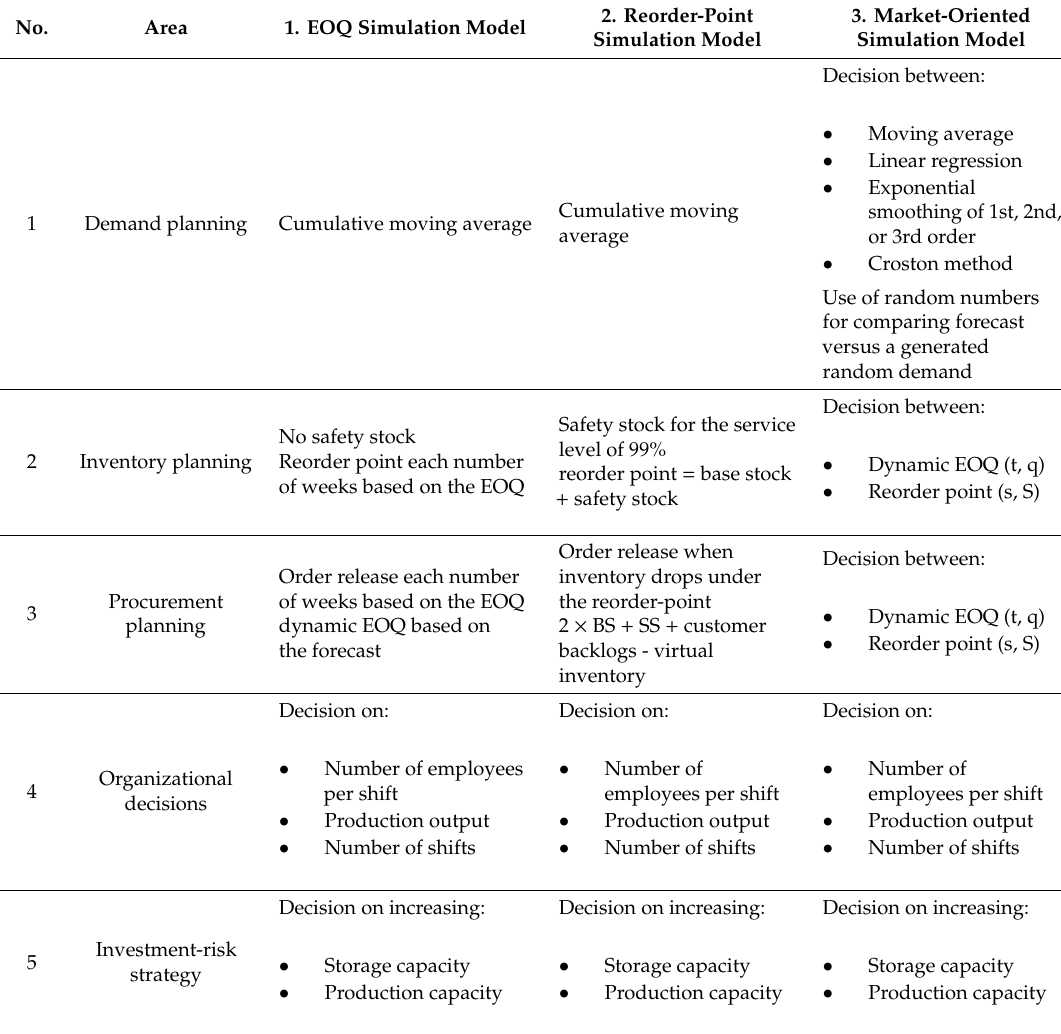
Table 8. Di ff erences between the simulation models (own